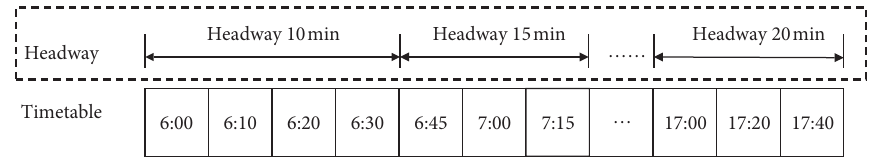
Figure 1: The example of the timetable based on headway.